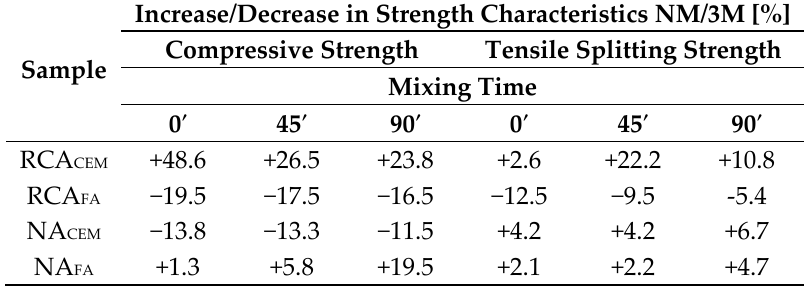
Table 1. Changes in strength characteristics of samples prepared by triple and normal mixing.